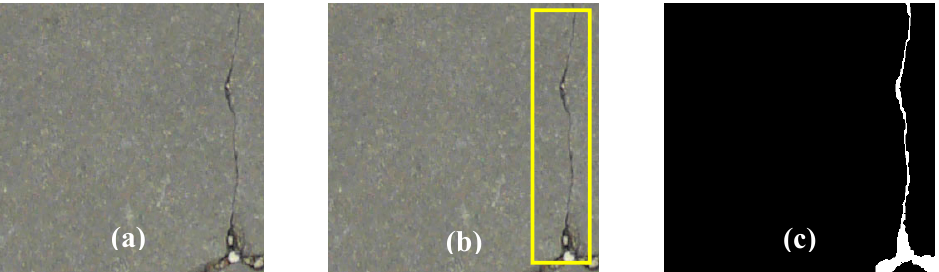
Figure 5. Illustration of ( a ) crack and non-crack image classification, ( b ) object localization, and ( c ) pixel-level segmentation (open-access images from Yang et al. [102]).